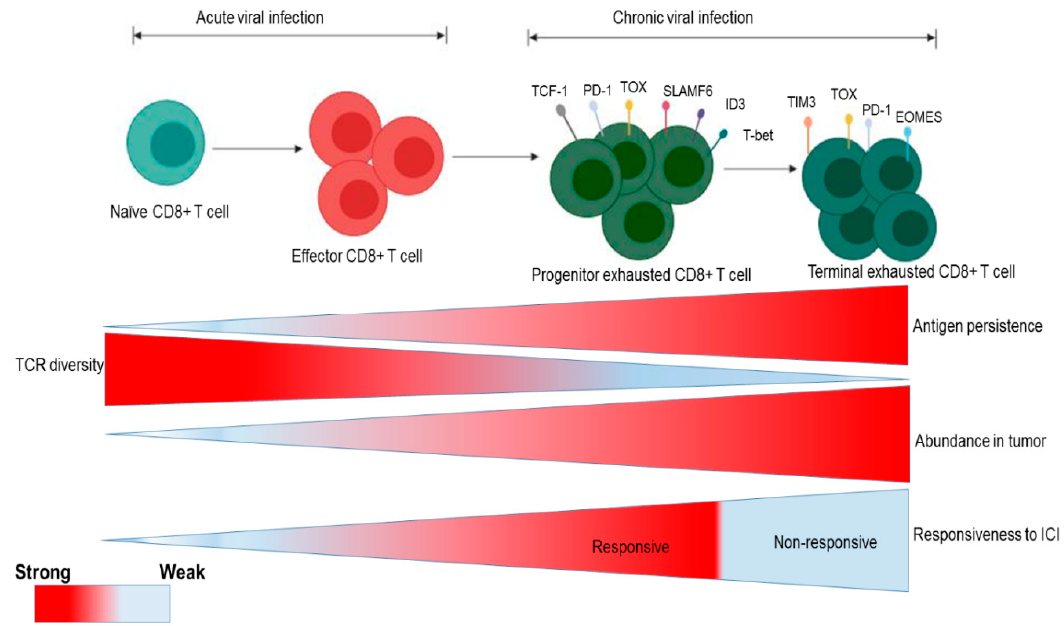
Figure 3. Viral infection promotes T cell exhaustion. The chronicity of viral infection determines the fate of CD8 + T cell. During acute viral infection, naïve CD8 + T cells differentiate into effector CD8 + T cells. These subset of effector CD8 + T cells possess an effective cytotoxic activity through diverse T cell receptor (TCR). However, chronic viral infection promotes antigen persistence, causing expression of exhaustion markers on T cells and a phenotype switch to an exhausted state. Exhausted T cells have two subpopulations; progenitor exhausted and terminally exhausted T cells. The progenitor exhausted T cells are responsive to immune checkpoint inhibitor (ICI), whereas terminally exhausted T cells are more abundant within the tumor and are non-responsive to immune checkpoint inhibitor